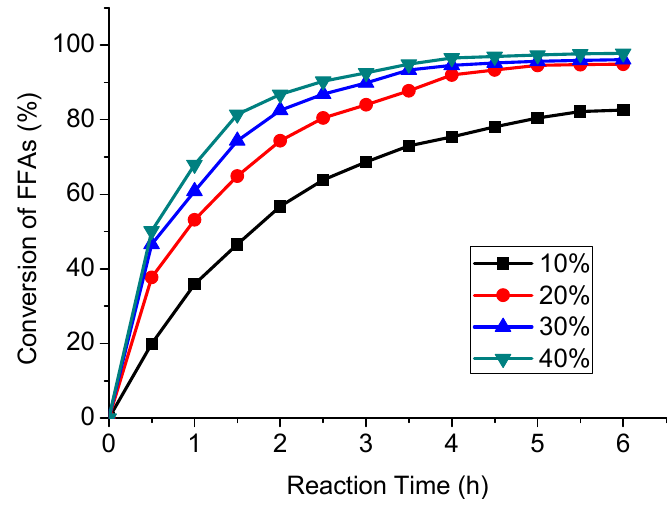
Figure 1. Effect of methanol/WCO volume ratios on the